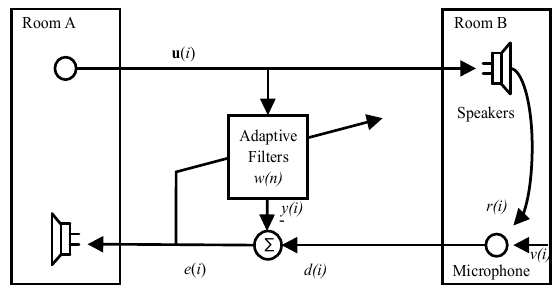
Figure 11. Principle diagram of echo cancellation.